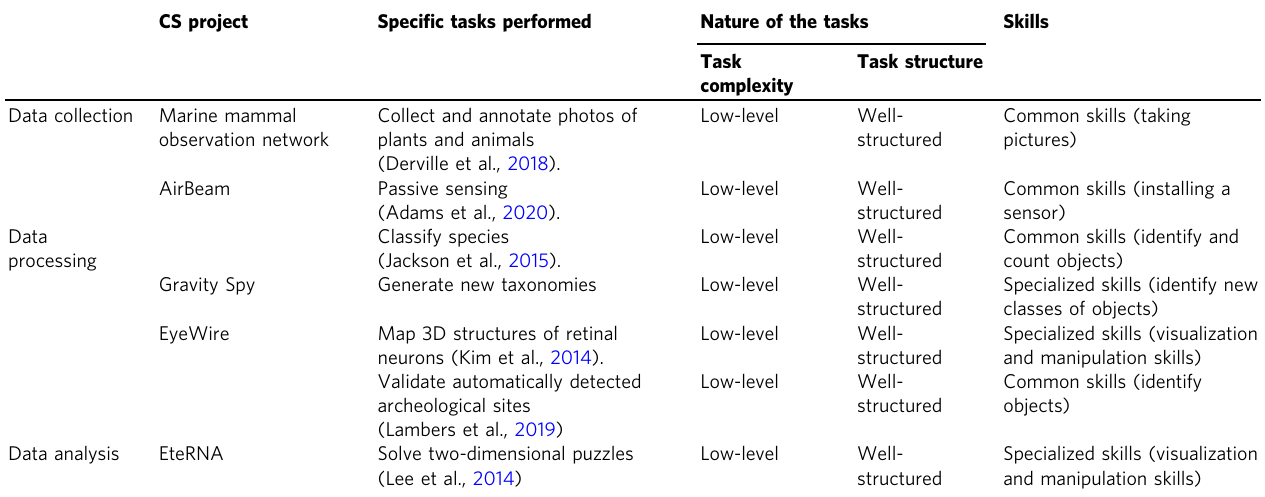
Table 5 Tasks performed by citizen scientists and skills needed across the activities — examples from the literature.